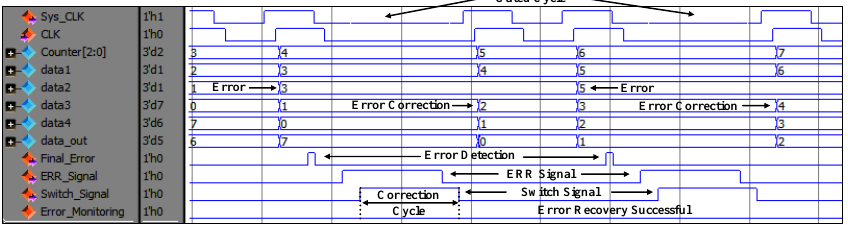
Figure 8. Simulated waveforms of the proposed EDACFF